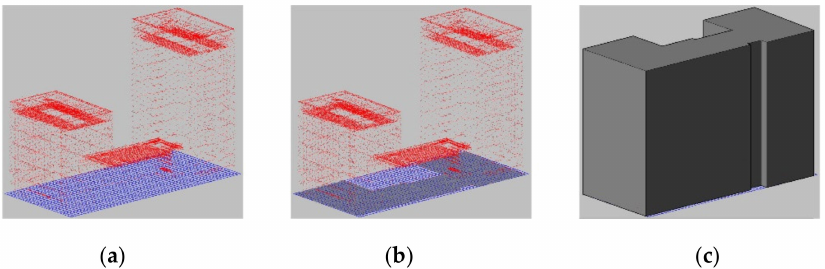
Figure 5. Marking of a 2D grid: ( a ) Building point cloud projected into a two-dimensional grid of xoy plane; ( b ) marking grid with a point cloud; ( c ) building volume based on the projected area stretch.